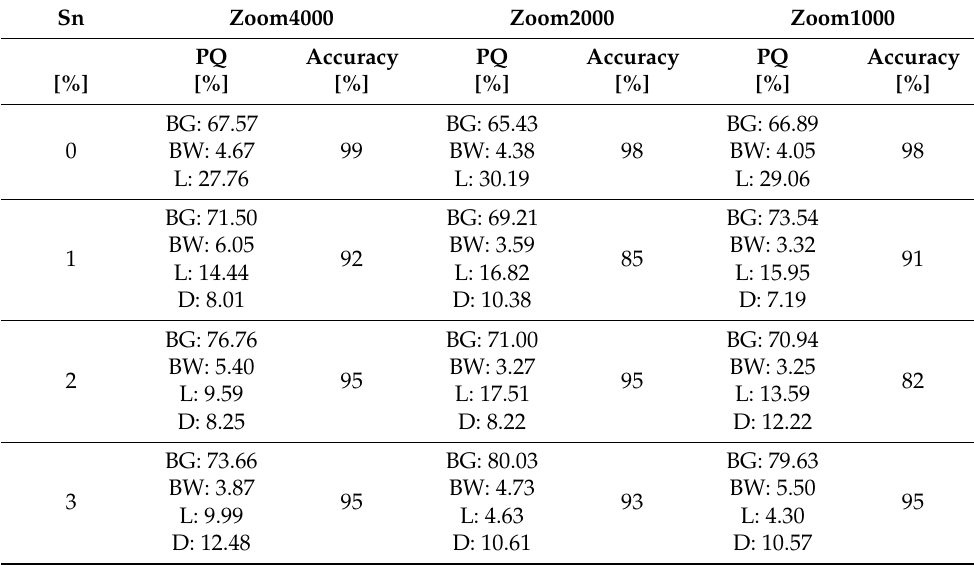
Figure 9. Segmentation and classification (a detail section from a Zoom4000, 3% Sn image).